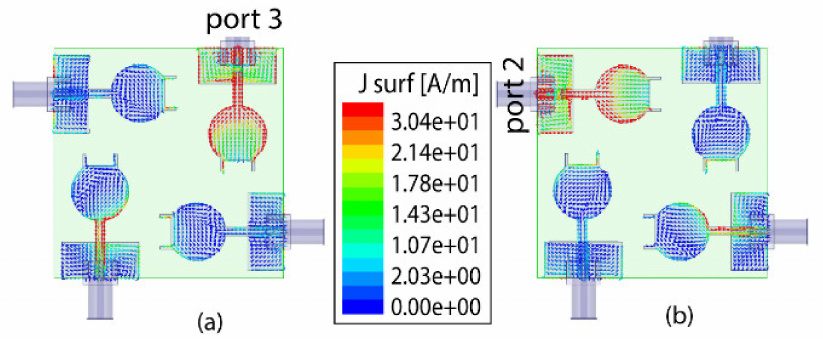
Figure 7. Screenshots of the current density at surface of the antenna operating at 5.5 GHz while excited ports are ( a ) 3, ( b ) 2.